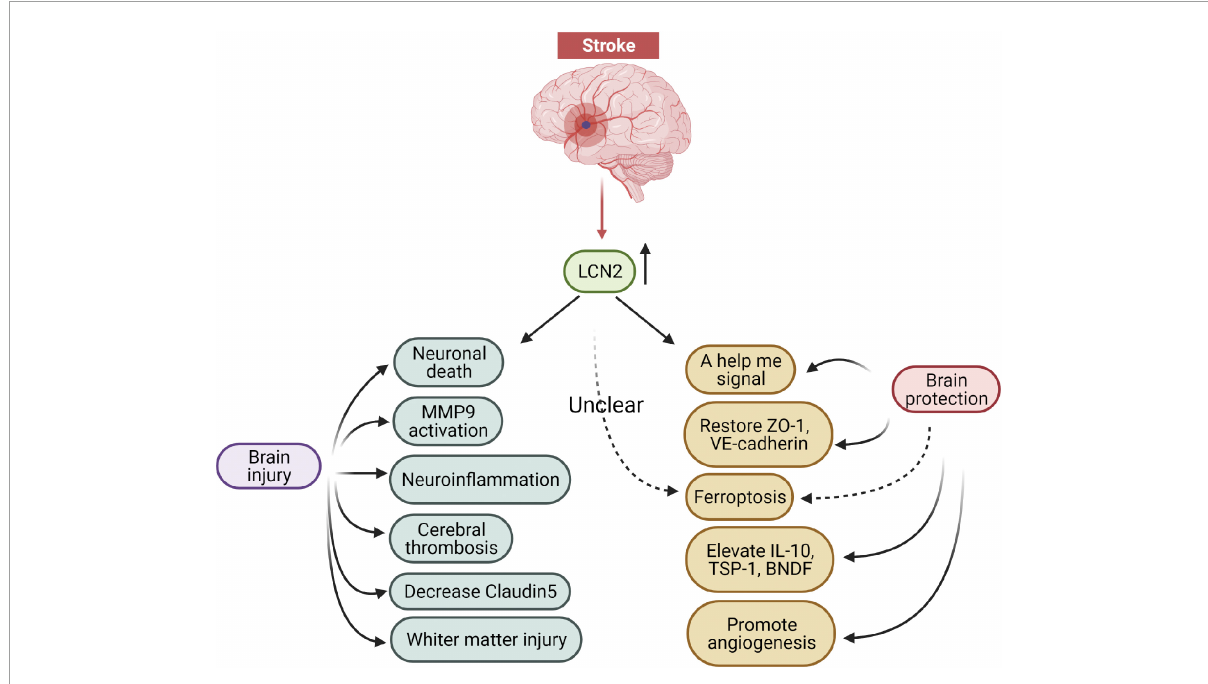
FIGURE5 The damage and protection mechanisms of LCN2 in the brain after